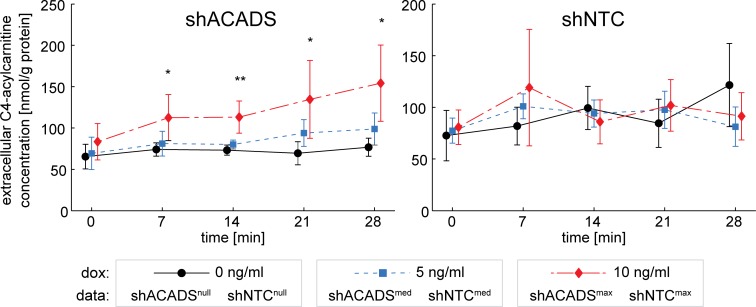
Time courses of extracellular C4-acylcarnitine after palmitic acid loading.Palmitic acid was added to induce FAO in shACADS and shNTC Huh7 cells. C4-acylcarnitine, which accumulates within the cell due to the ACADS knockdown, also accumulates in the supernatant. Gradual expression of shRNA was induced using 0, 5 and 10 ng/mL doxycycline. C4 was measured in supernatants before palmitic acid loading and after 7, 14, 21 and 28 min. Values of four independent experiments are expressed as mean ± SD. (original data of single measurements are given in S1C and S1D Table). **: p < 0.01, *: p < 0.05 comparison between shACADS dox 0 ng/mL and shACADS dox 10 ng/mL (two-sample t-test).